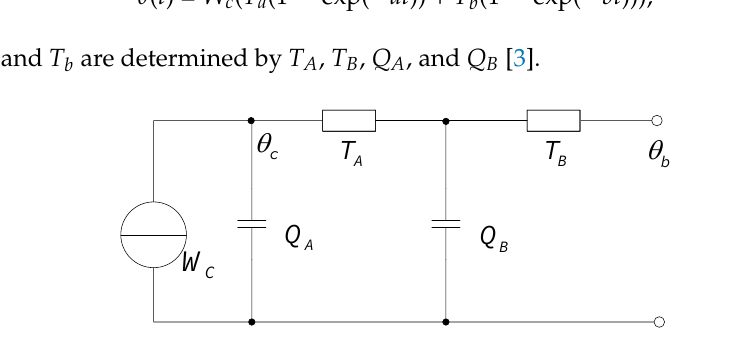
Figure 3. Simplified transient thermal circuit model from insulation shield to conductor.